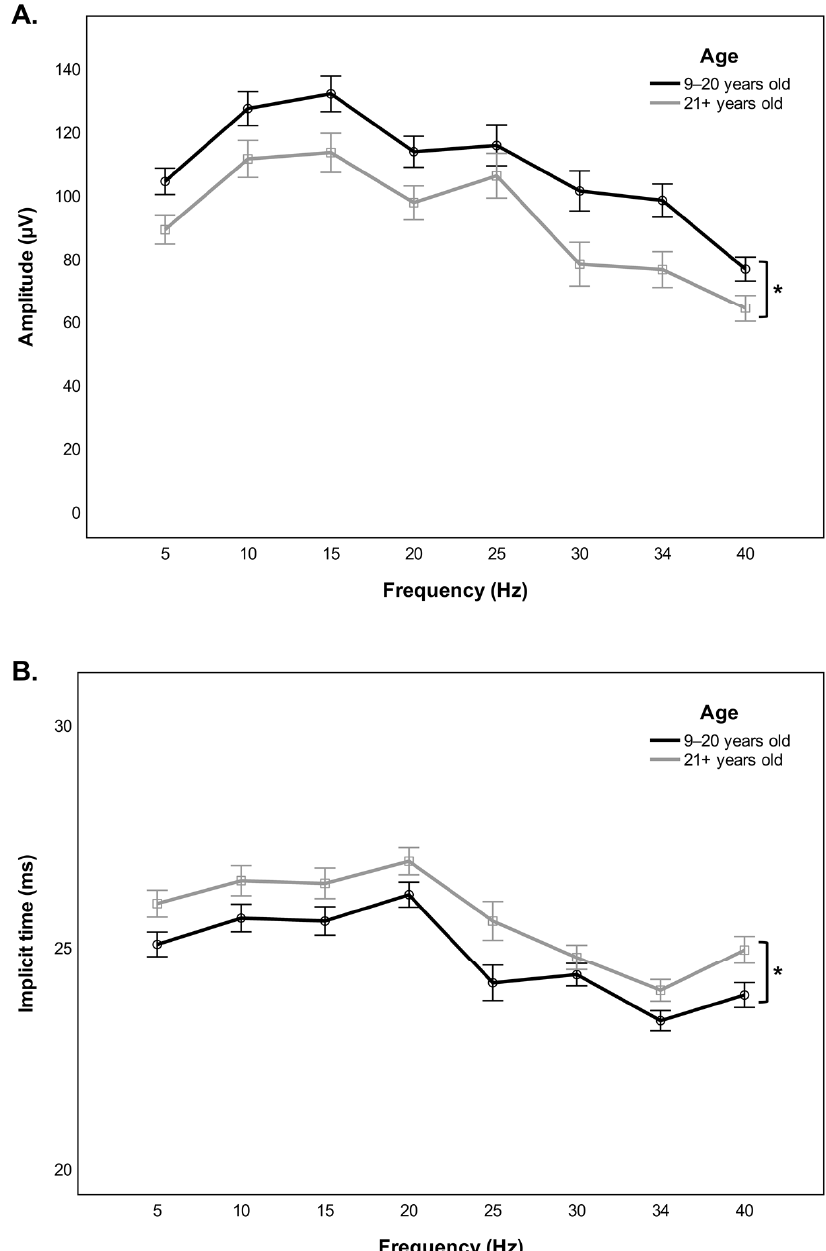
Figure 2. Frequency-amplitude ( A ) and frequency-implicit time ( B ) functions show differences in the flicker ERG stimulus-response characteristics between younger (9–20 years old) and older (21+ years old) monkeys. Responses were elicited at eight different flash frequencies. Error bars represent standard errors of the mean (SEM). * p < 0.05